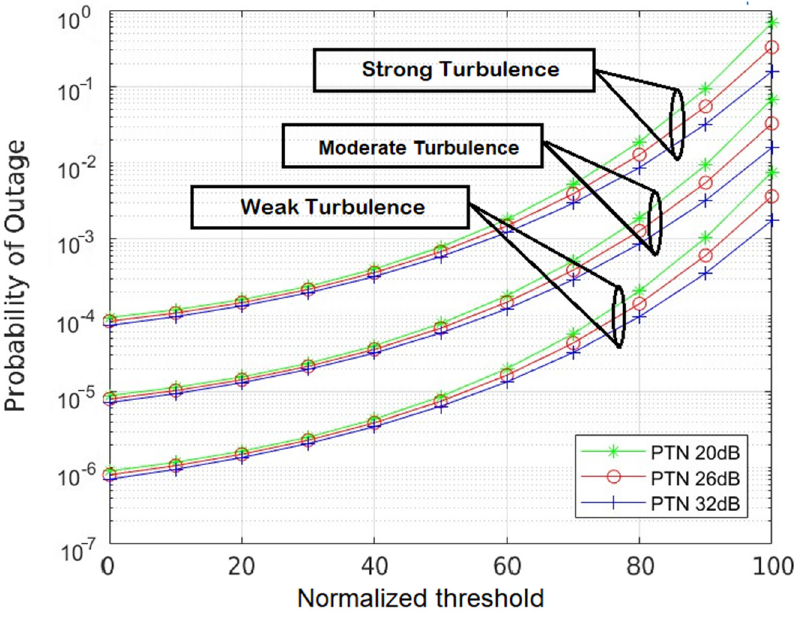
Figure 2. Probability of outage for the fixed